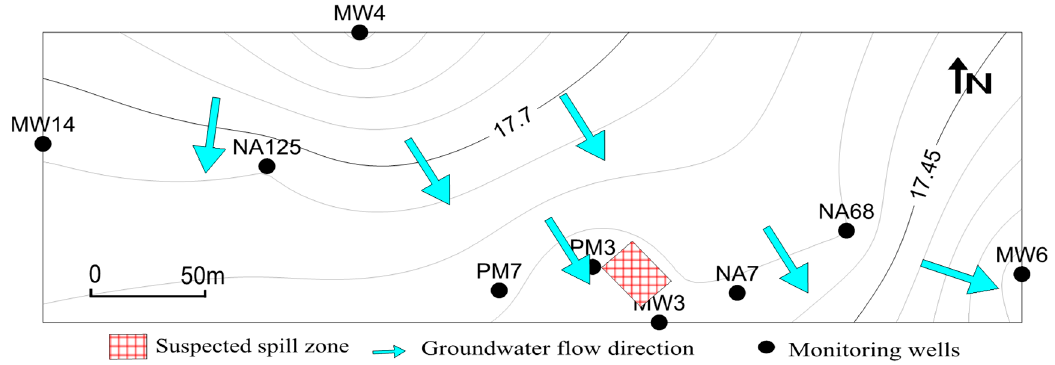
Figure 1. Map showing suspected spill zone, monitoring wells, and groundwater flow.